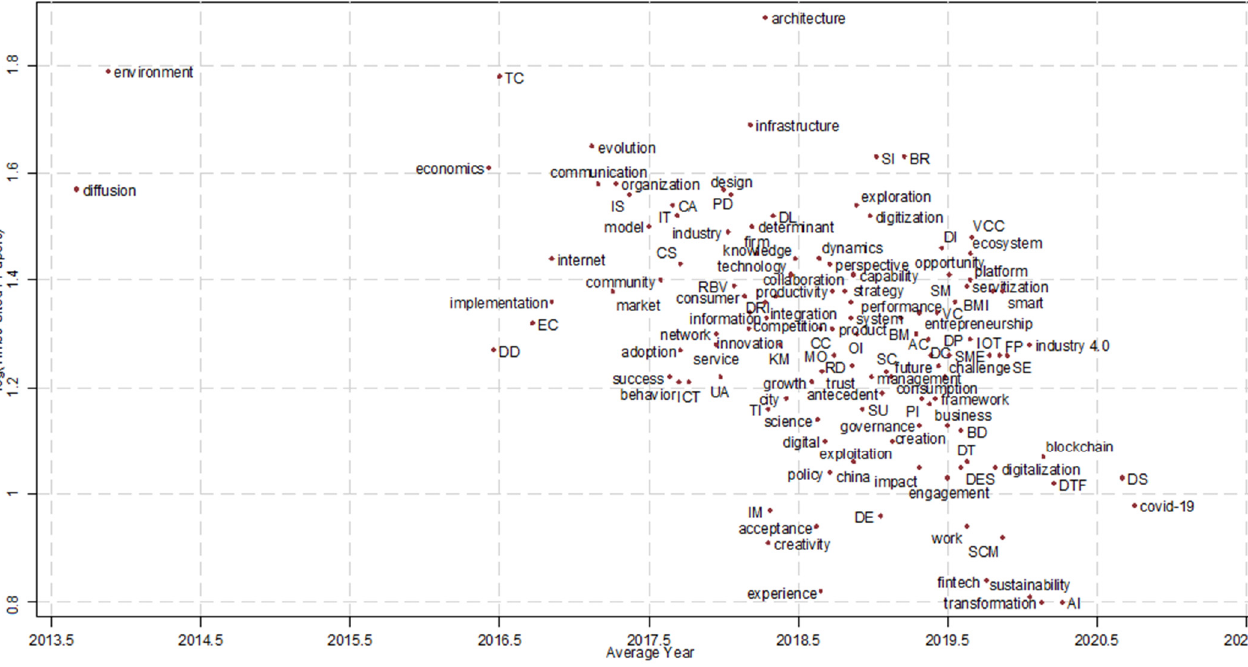
Figure 9. Longitudinal analysis of the most significant clusters.